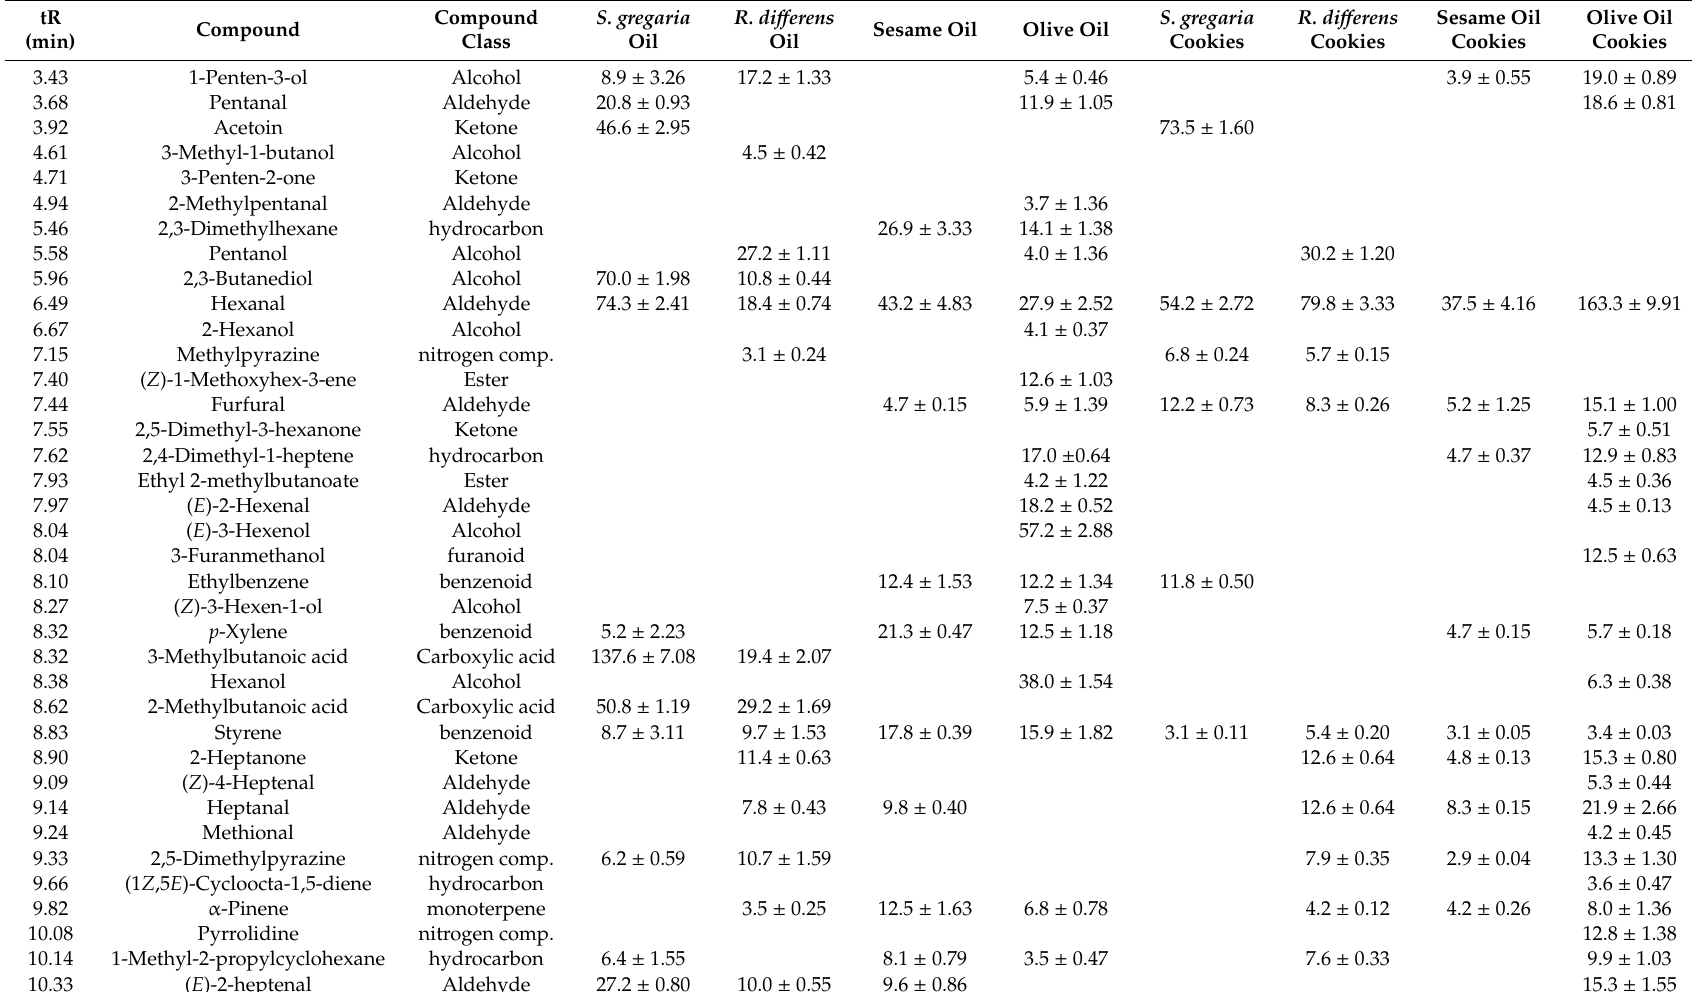
Table 3. Volatile organic compounds (ng / g / h a ) of the selected oils from insects, plants, and cookies analyzed by